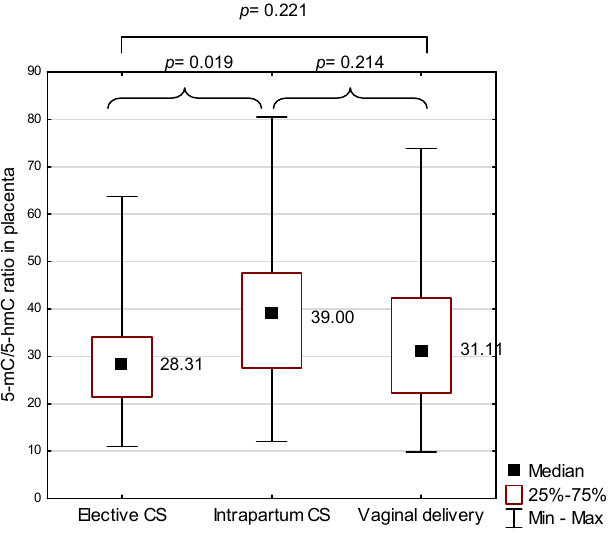
Figure 2. The 5-methylcytosine to 5-hydroxymethylcytosine (5-mC/5-hmC)ratio in the placenta against the mode of birth; p represents results from the Mann–Whitney U test to compare 5-mC/5-hmC ratio in the placenta between two modes of birth. CS—cesarean section. A positive correlation occurred between 5-mC/5-hmC ratio and the weight gain during pregnancy expressed in kg ( r = 0.238, p = 0.047). The 5-mC/5-hmC ratio did not